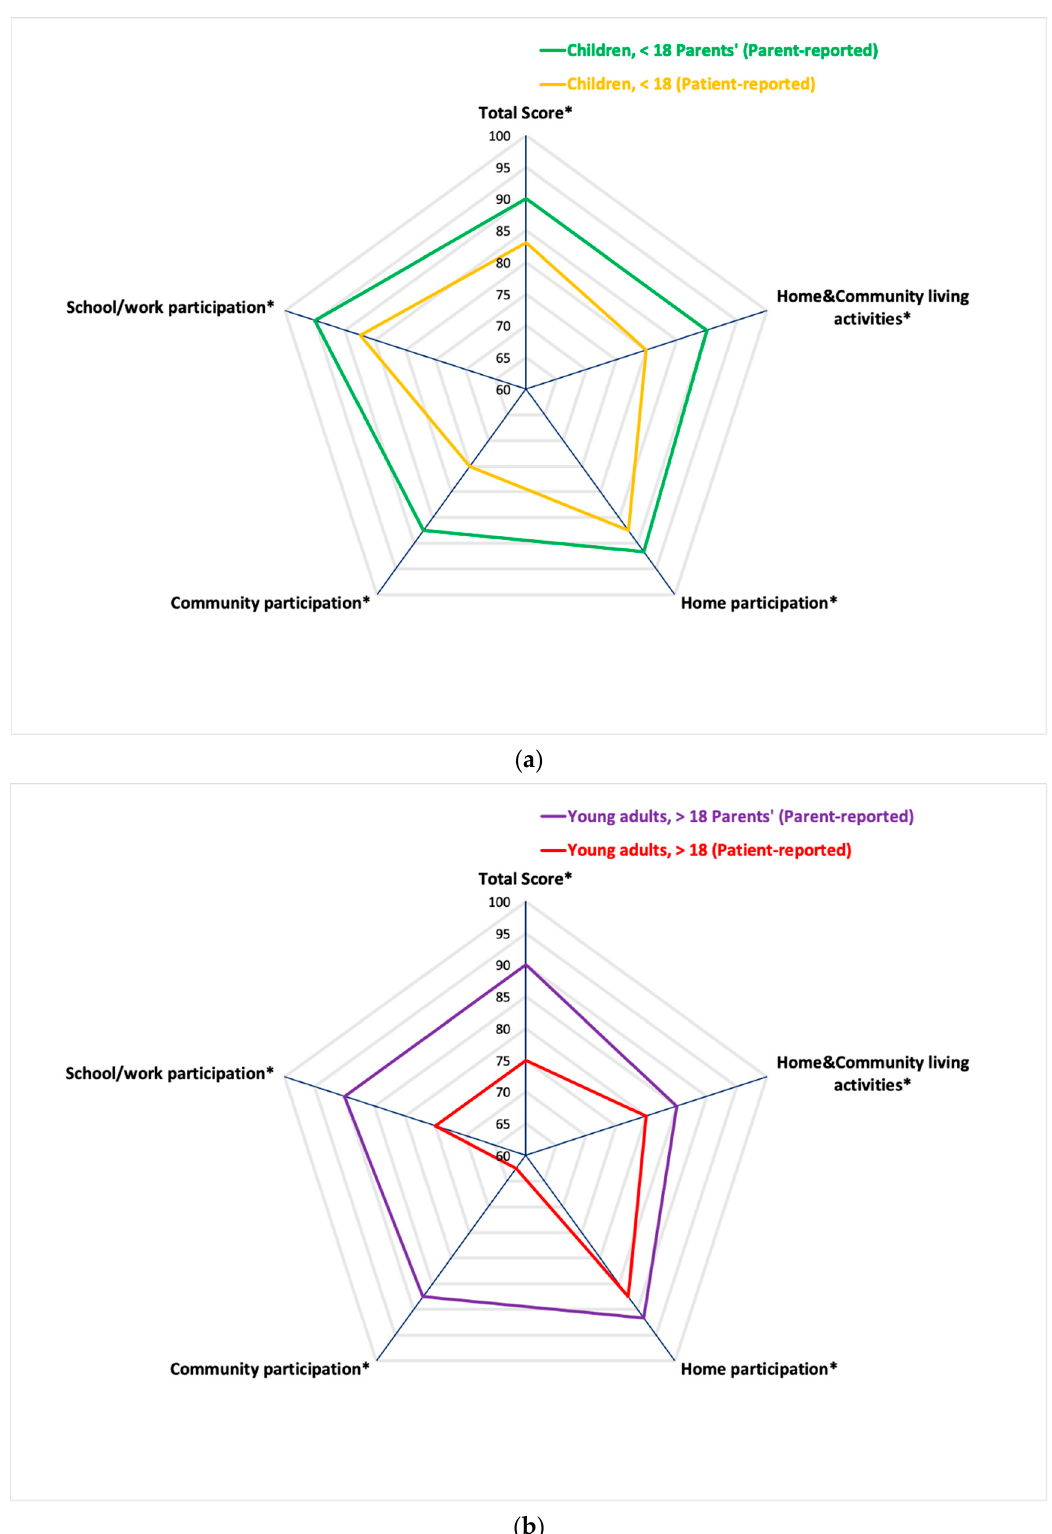
Figure 2. ( a ) Differences in CASP scores between Patients and Parents in children (5–17 years) with ABI. * CASP: Child and Adolescent Scale of Participation, 0–100 with lower scores indicating more participation restrictions. ( b ) Differences in CASP scores between Patients and Parents in young adults (18–24 years) with ABI. * CASP: Child and Adolescent Scale of Participation, 0–100 with lower scores indicating more participation restrictions.